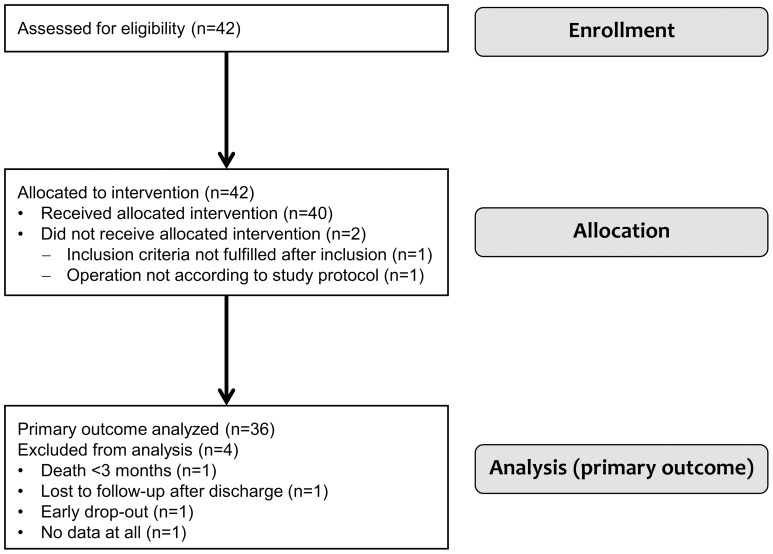
CONSORT (Consolidated Standards of Reporting Trials) flow diagram presenting the enrollment, intervention allocation, and data analysis of the study.